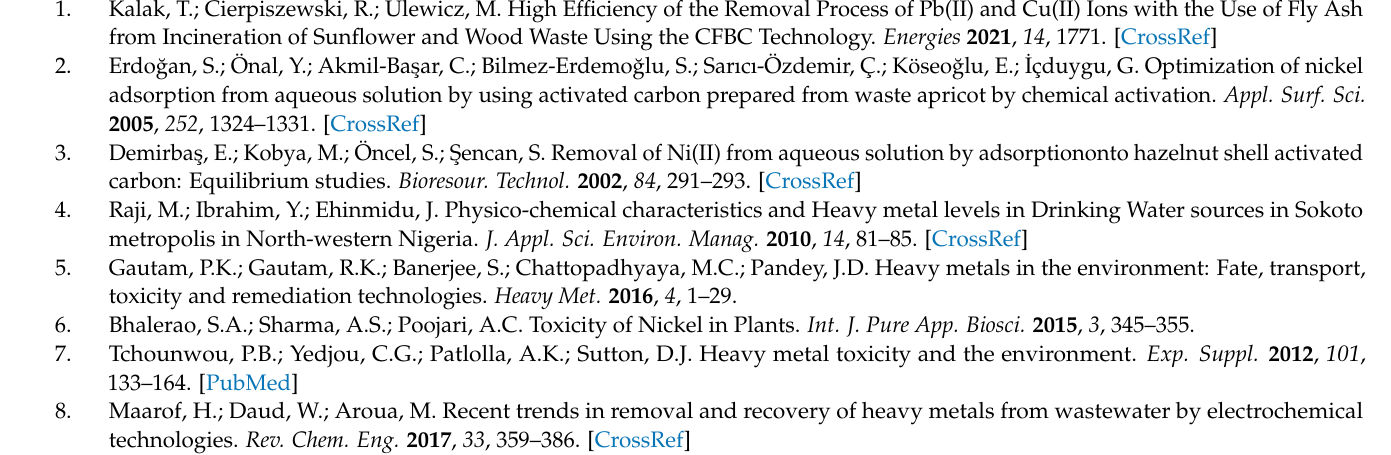
diffraction; Figure S2. The low temperature BET adsorption and desorption isotherm; Figure S3. Linear form of BET adsorption isotherm; Figure S4. Pore volume distribution (the BJH method); Figure S5. Langmuir isotherms for adsorption of Ni(II) ions with SS-FA; Figure S6. Freundlich isotherms for adsorption of Ni(II) ions with